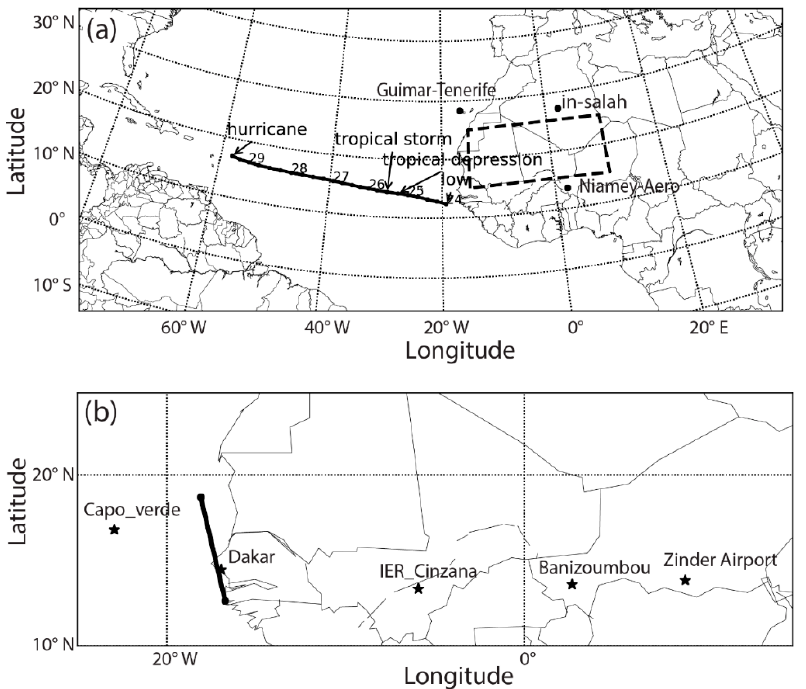
Figure 1. Panel ( a ) shows the WRF domain, the best track from the National Hurricane Center in the US (NHC), and the locations of radiosondes. The numbers beside the best track indicate the corresponding dates of the positions of tropical cyclone (TC) in August 2010. The box over North Africa (15~25 ◦ N, 15 ◦ W~10 ◦ E) indicates the area where the horizontal averages of the variables are taken in Section 3. Panel ( b ) shows the locations of the AERONET sites. The line corresponds to the position of the cross-section at 1400 UTC 23 August 2010, where the modeled AOD is compared with the CALIPSO data.